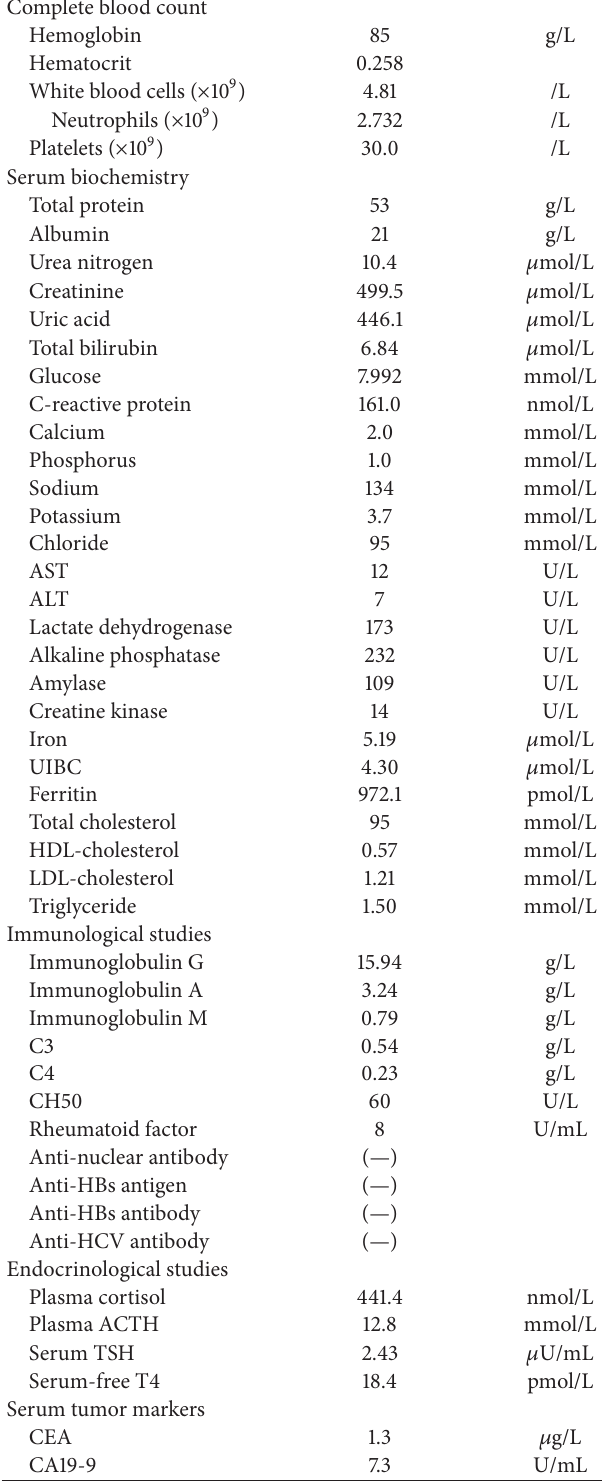
Table 1: Results of laboratory tests conducted on